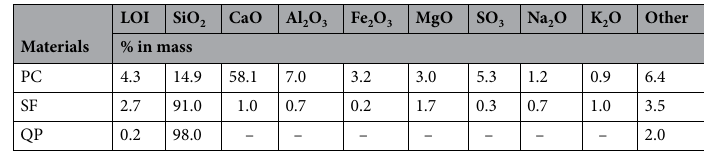
Table 1. Chemical characterization of materials. LOI loss on ignition.